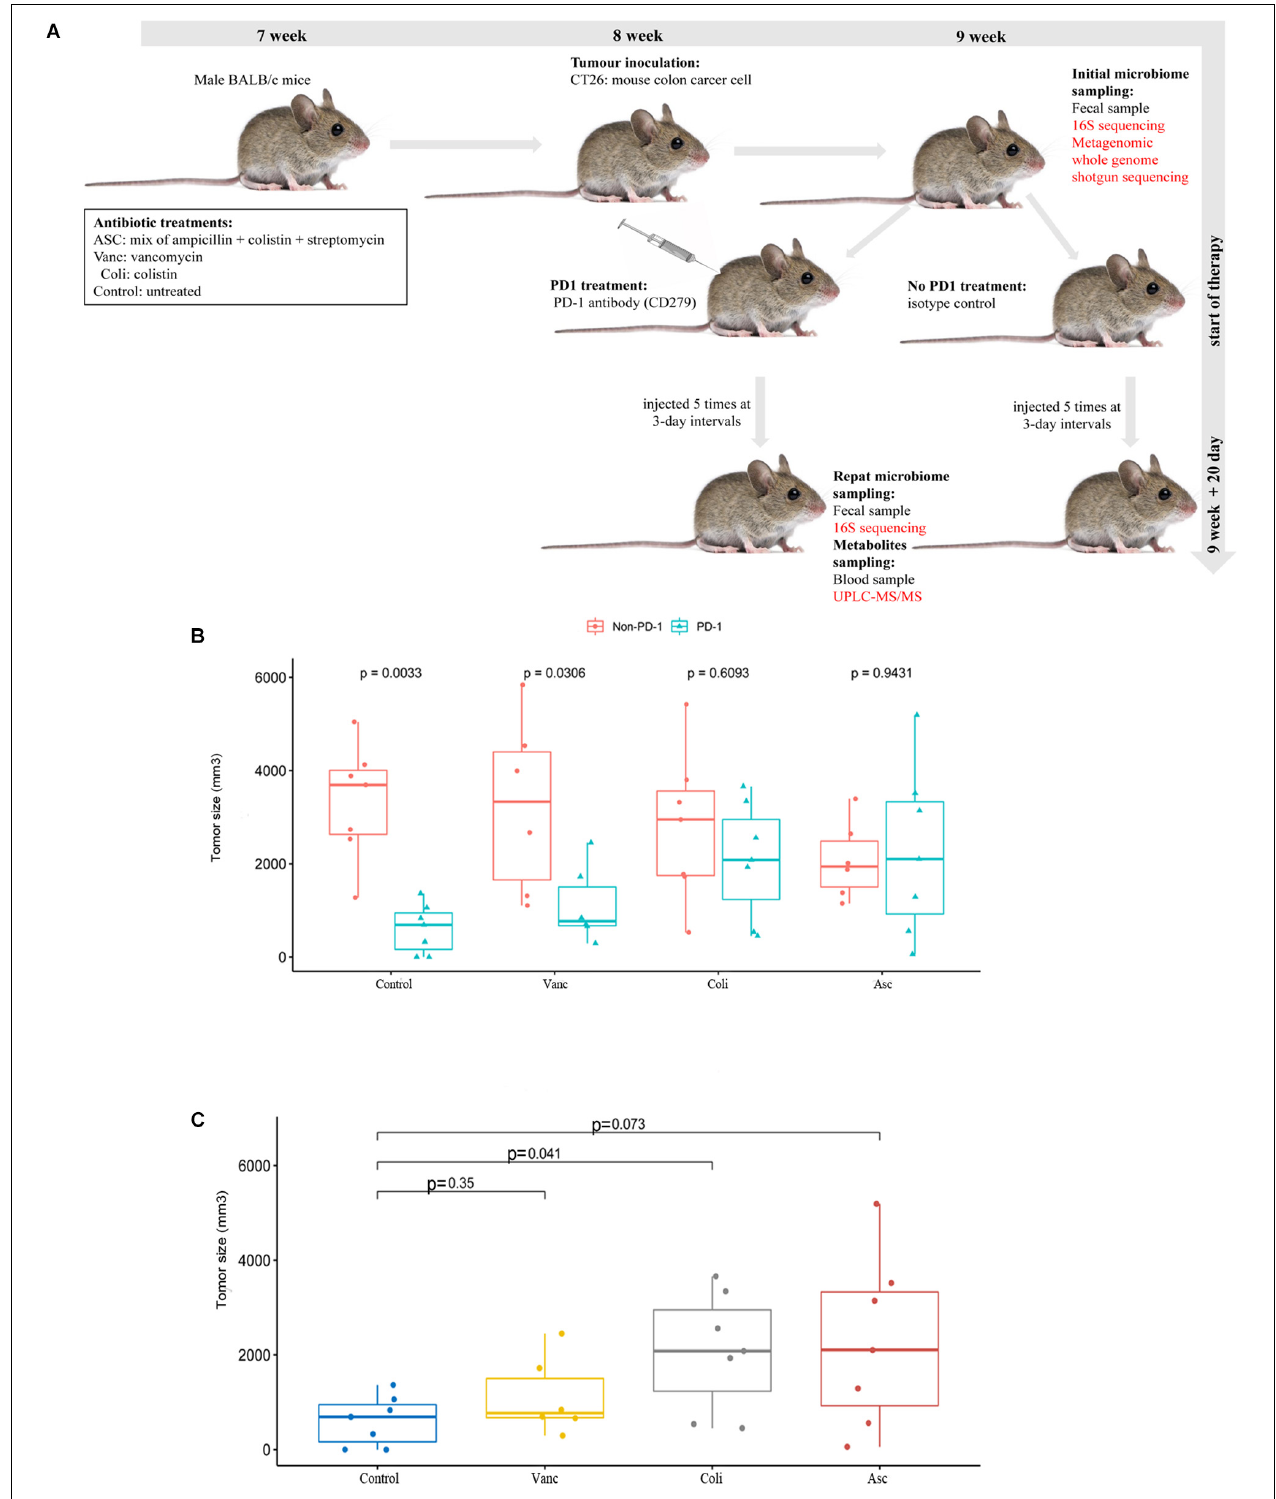
FIGURE 1 | Effect of PD-1 antibody immunotherapy on the diversity of CT26 tumor-bearing mice with different gut microbiome. (A) Schematic diagram of mouse model experiment process and sample collection and analysis. (B) Tumor size of mice at the end of immunotherapy. (C) Tumor size of mice at the end of immunotherapy in the presence of different antibiotic regimen in each group.